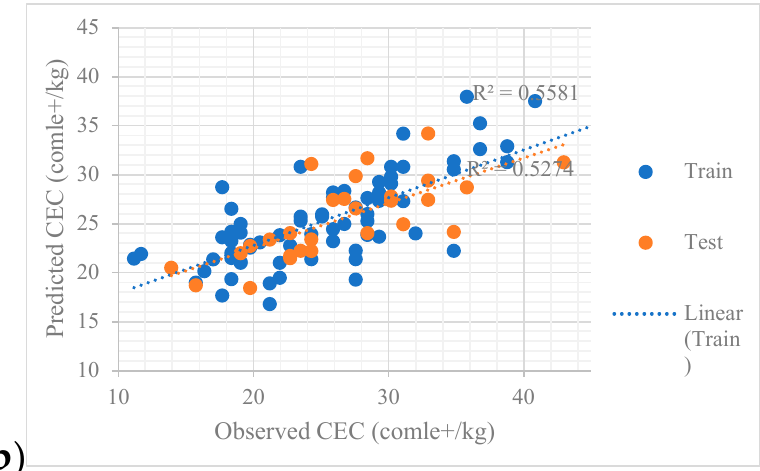
Figure 5. Observed CEC values versus the predicted values by RF model ( a ) and Cu model ( b ) in the training and testing datasets.